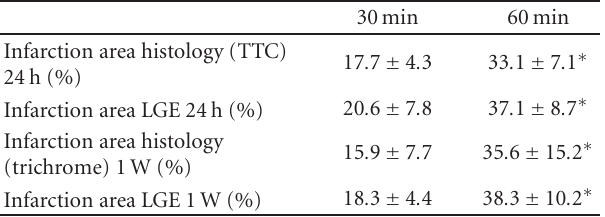
Table 1: Infarct size in mouse heart after I/R procedure. Infarct size measured in magnetic resonance imaging by LGE in magnetic resonance imaging and histology (24h after reperfusion by TTC staining and 1 week after reperfusion by trichrome staining). No infarction was detected in sham-operated mice. Values shown as mean percentage of left ventricular area ± standard deviation. ∗ Significant di ff erence to 30min ischemia operated mice, all P < . 05. 30min 60min Infarction area histology